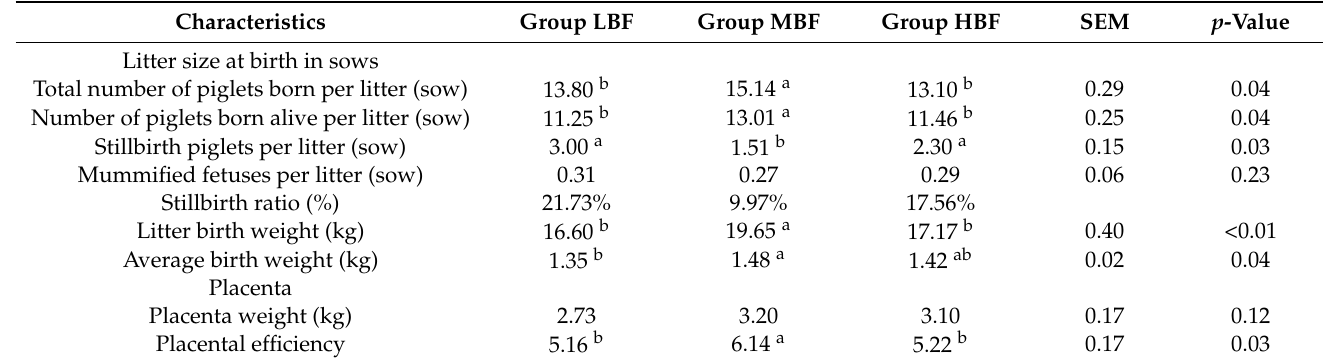
Table 1. Characteristics of sows and newborn piglets at farrowing 1